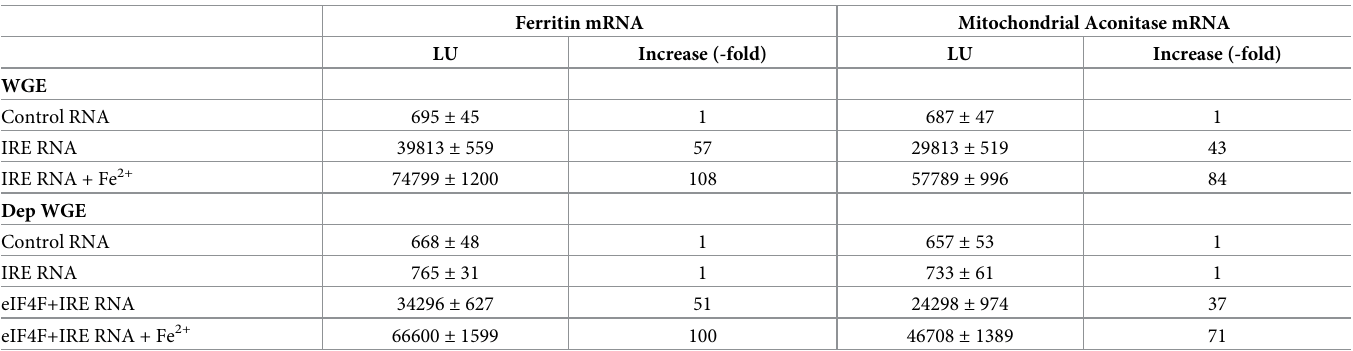
Table 2. eIF4F supports translation of ferritin and mitochondrial aconitase IRE luciferase reporter.